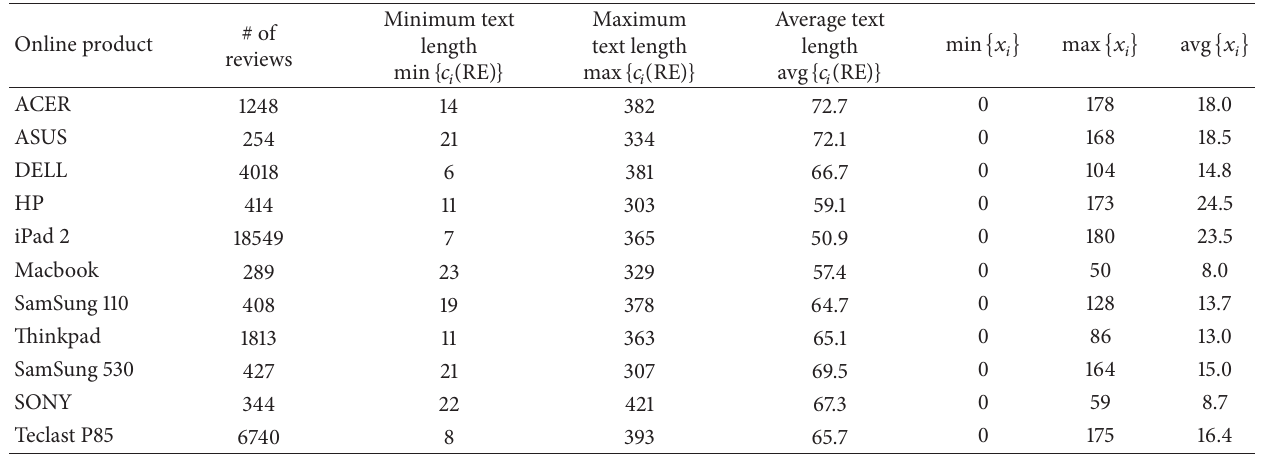
Table 3: Descriptive statistics for the data